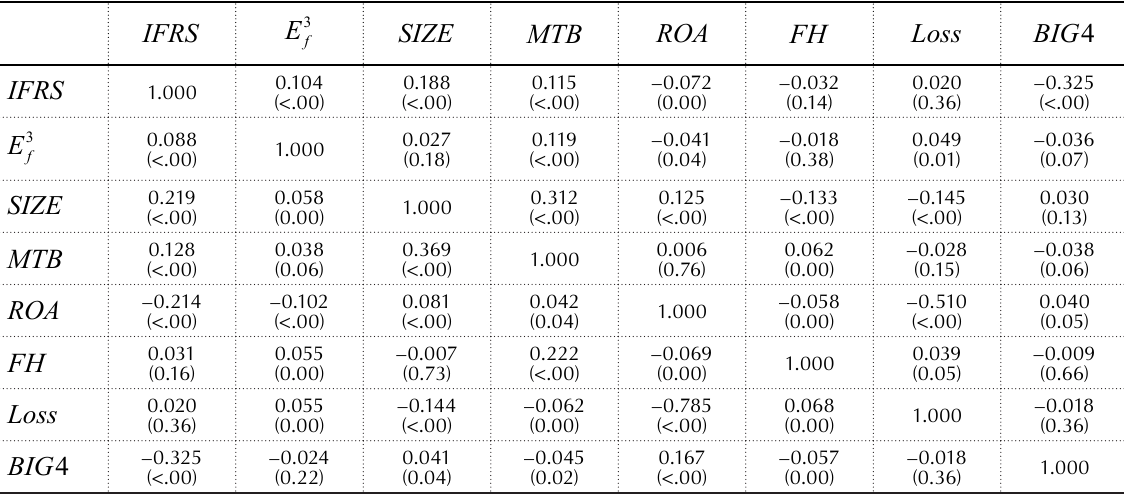
Table 2. Correlation